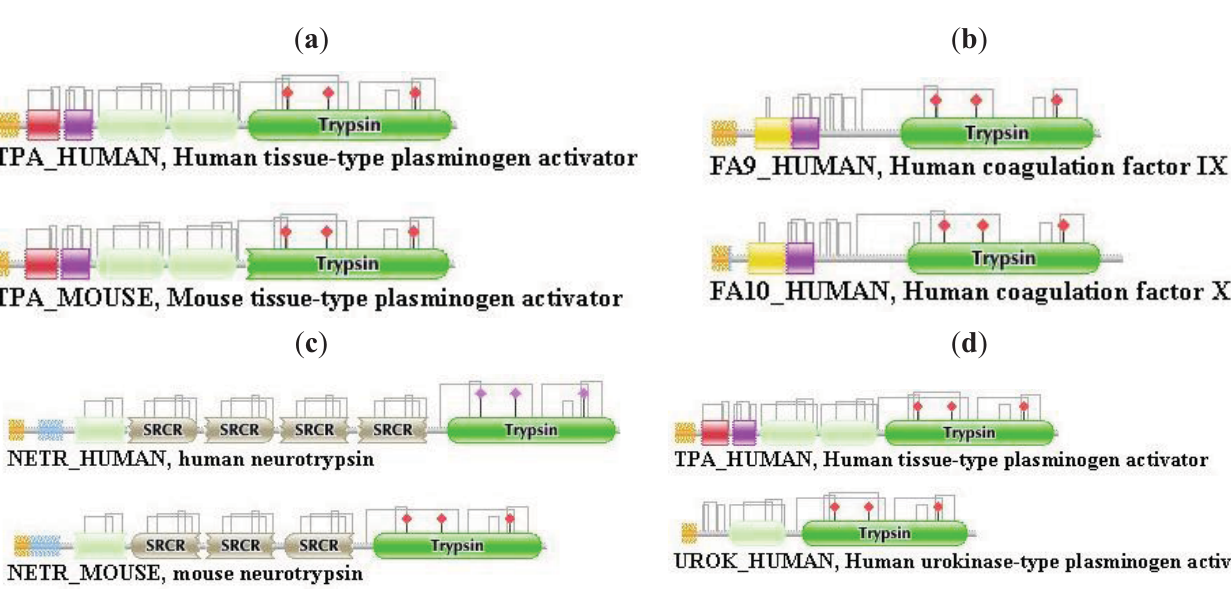
Figure 1. Types of homology of multidomain proteins: orthologs and paralogs. ( a ) Orthologous multidomain proteins with identical DA — human and mouse tissue plasminogen activator; ( b ) Paralogous multidomain proteins with identical DA — human factor 9 and human factor 10; ( c ) Orthologous multidomain proteins with different DA — human and mouse neurotrypsin; and ( d ) Paralogous multidomain proteins with different DA — human tPA and human